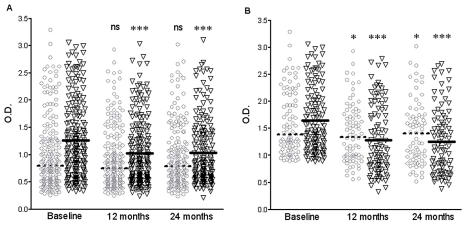
Effect of LNs on human exposure to P. argentipes and P. papatasi sand flies.Individual ELISA Optical Density (OD) per immunological survey (baseline, 12 and 24 months follow-up) for intervention (long-lasting insecticidal nets, LN – black triangles) and control clusters (grey circles), for Phlebotomus argentipes (Panel A) and P. papatasi (Panel B). The geometric means ELISA OD are represented as a solid line for LN and dotted line for control groups. Results represent all the samples available (n = 305). The Mann Whitney t-test was used to compare 12 and 24 month follow-up samples compared to their corresponding baseline values, asterisks denote statistical significance (*, P<0.05; **, P<0.005; *, P<0.005; ns, not significant P>0.05).